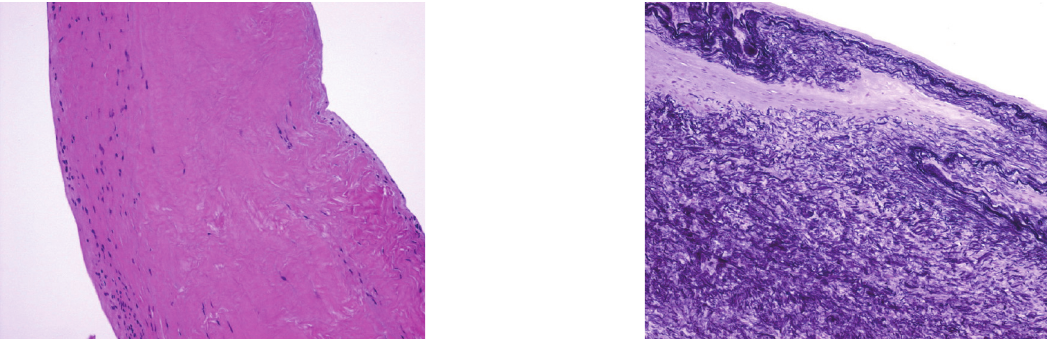
Erythematosus Roldan and colleges reported that the LE’s length was similar in patients with ( 11.9 ± 4.9 mm) and without ( 11.7 ± 3.5 mm) cerebrovascular disease and in controls ( 9.1 ± 3.4 mm) [24].